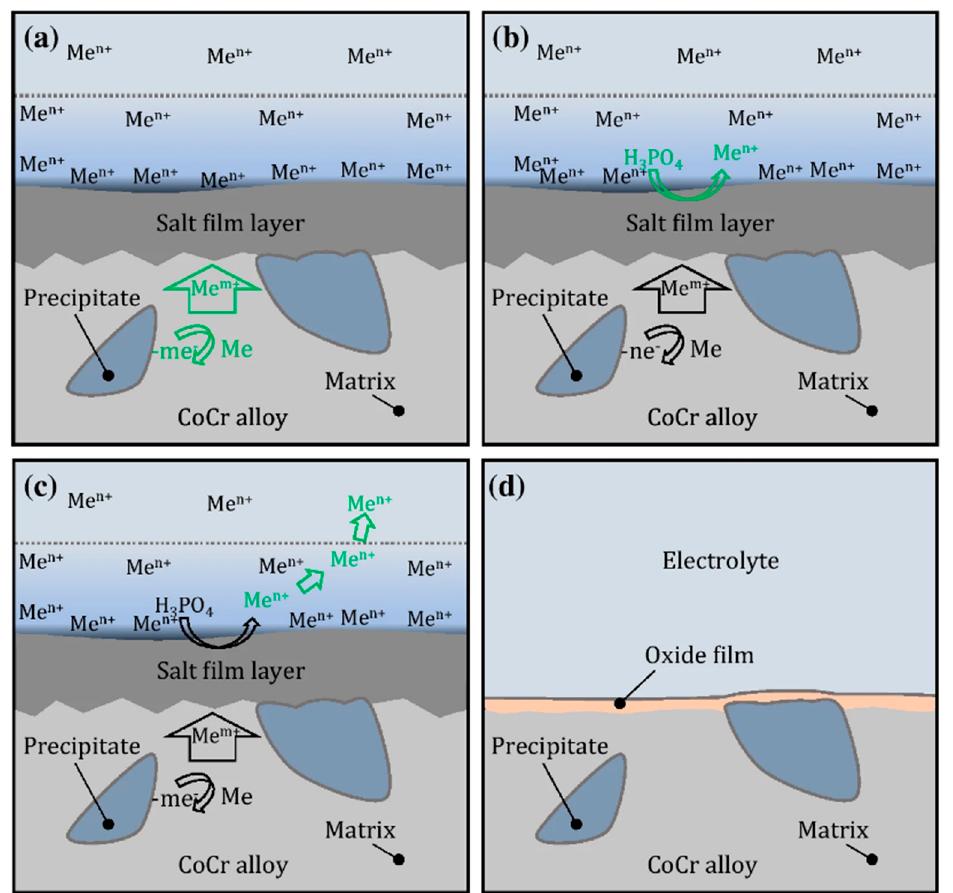
Figure 11. The electropolishing of CoCr dental implants in phosphoric acid, ( a ) initial formation of salt film layer, ( b ) formation of the anode and electrolyte ions, ( c ) movement of anode ions through the salt film, ( d ) an electropolished (levelled) surface of metal with oxide film formed [116].